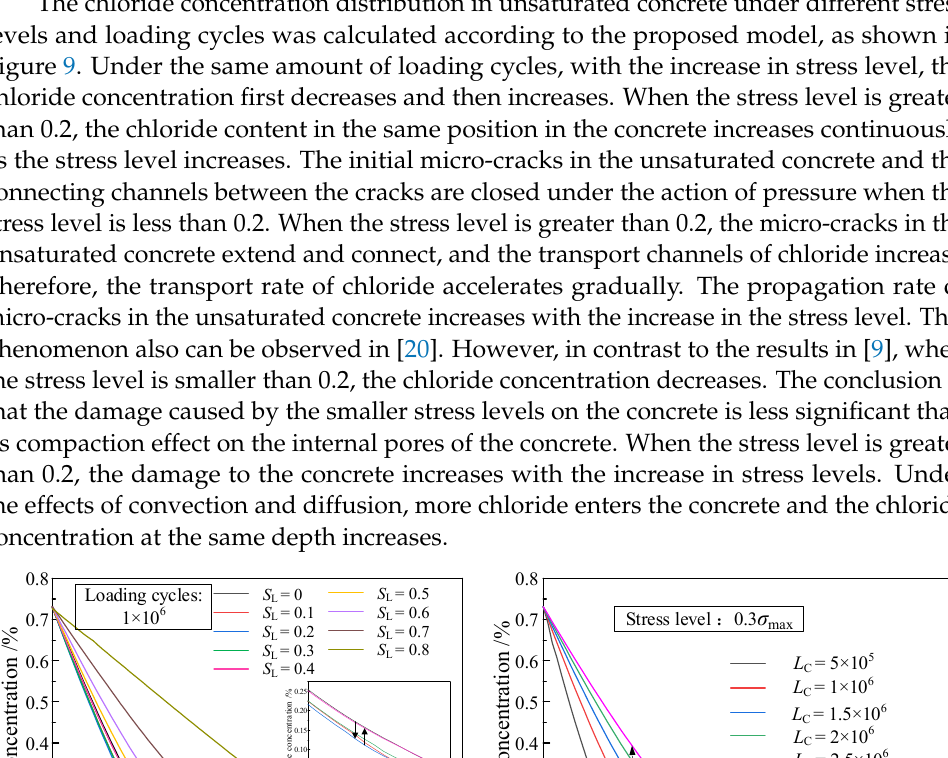
Figure 10. Chloride transport in unsaturated and saturated concrete under repeated loading: ( a ) normalized comparison and ( b ) schematic diagram. The transport depth of chloride in unsaturated concrete is significantly larger than that in saturated concrete, as shown in Figure 10. When the normalized corrosion depth is greater than 0.3, the chloride concentration in saturated concrete is less than 0.1. When the normalized corrosion depth of unsaturated concrete is greater than 0.55, the chloride concentration becomes insignificant. The corrosion depth of unsaturated concrete is roughly twice of the saturated concrete, and the concentration distribution is more uni- form, as shown in Figure 10b. Therefore, compared with saturated concrete, the chloride concentration and corrosion depth of unsaturated concrete are both higher under re- peated loading. The corrosion effect of chloride is more pronounced for unsaturated con- crete.